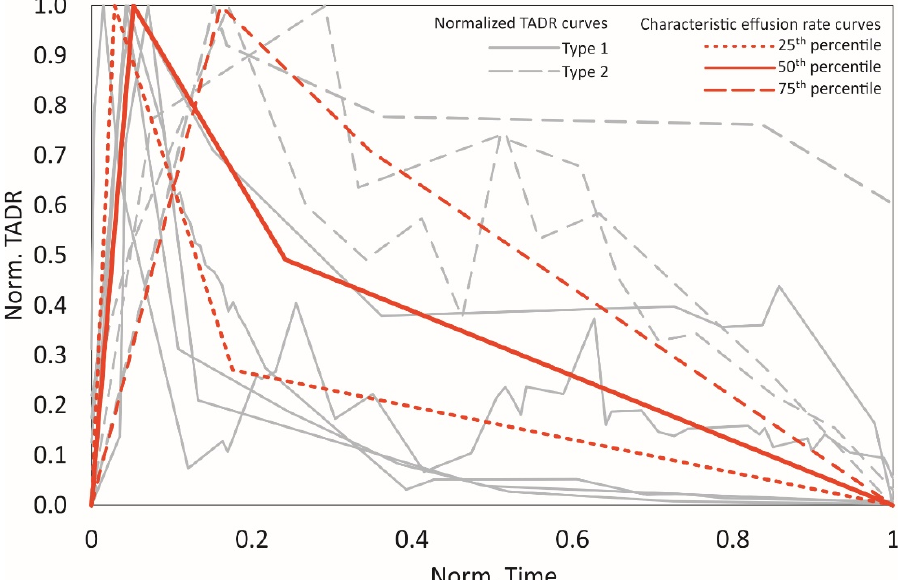
Figure 6. Diagram showing the “characteristic” effusion rate curves defined by the calculation of the 25th percentiles (dotted red line), 50th percentiles (solid red line) and 75th percentiles (dashed red line) of incidence of the effusion rate peaks and the inflection points from the normalized TADRs (solid grey line: Trend 1; dashed grey line: Trend 2).